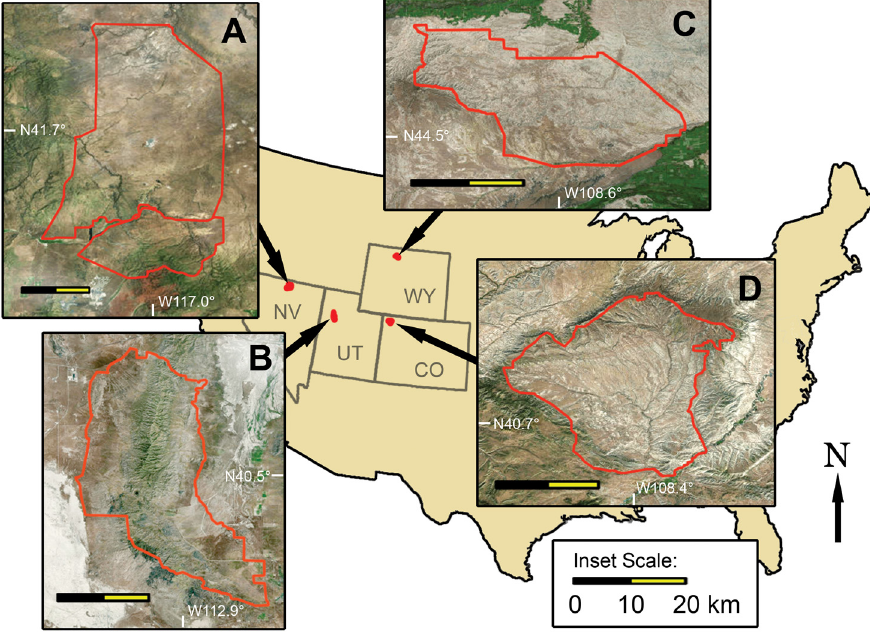
Fig 1. Map of aerial survey areas of feral horse ( Equus caballus ) populations in the United States. Location and topography of four U.S. Bureau of Land Management Herd Management Areas (HMA) surveyed: (A) Little Owyhee-Snowstorm Mountain HMAs, NV; (B) Cedar Mountain HMA, Utah; (C) McCullough Peaks HMA, Wyoming; and (D) Sand Wash HMA, Colorado,